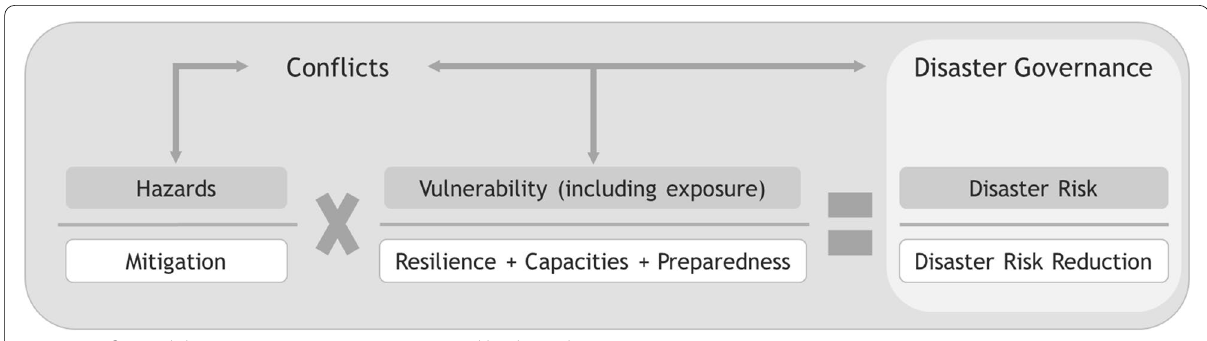
Fig. 1 Conflict and disaster governance. Source: prepared by the